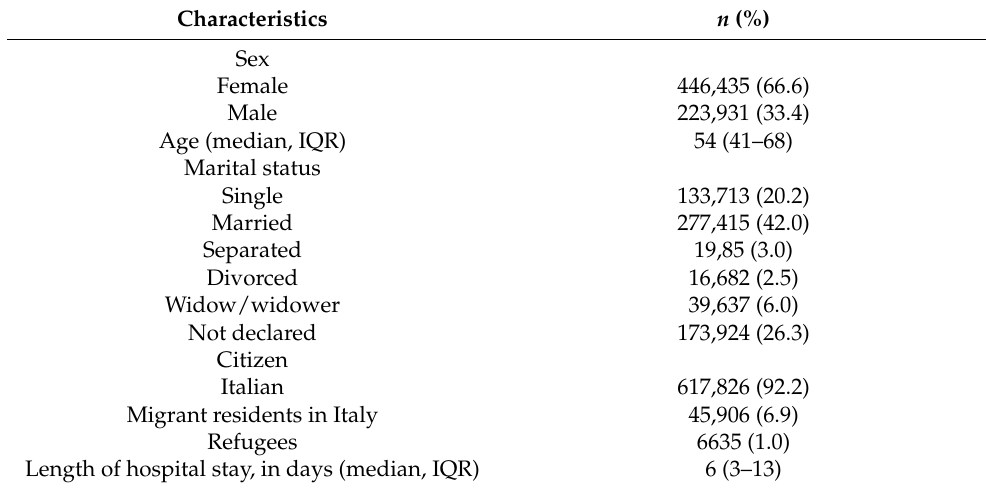
Table 1. Socio-demographic and clinical characteristics, as reported in the Italian hospital discharge records (HDRs) due to all HPV-related